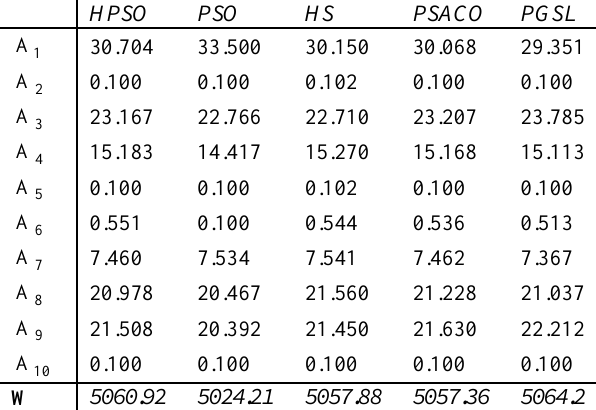
Fig. 2. Ten-bar truss, evolution of the cost function Table 2. 10-bar truss: optimal design comparison for case 1